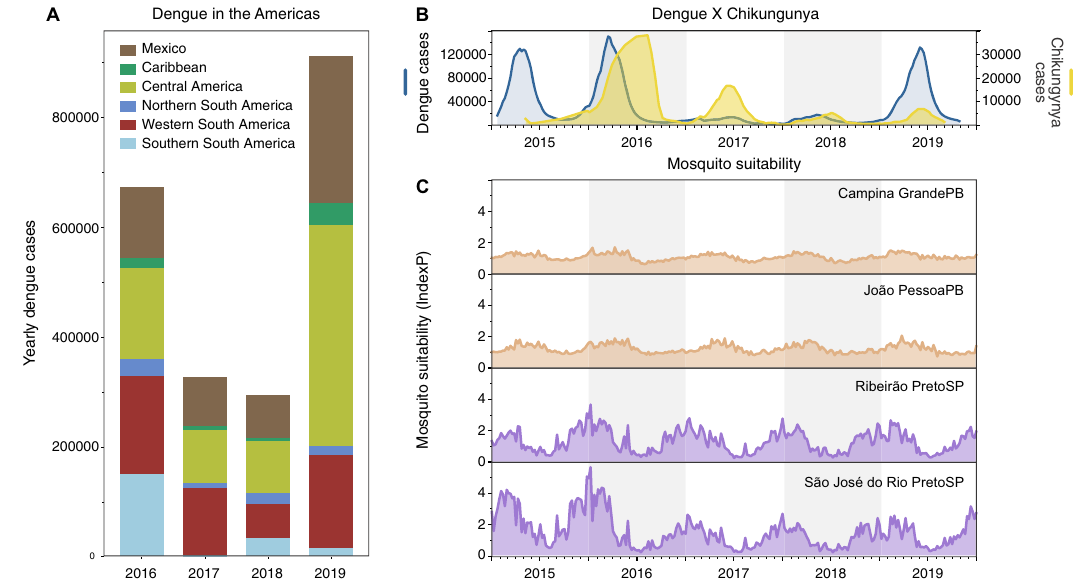
Fig. 4 Low dengue cases in 2017 – 2018 not primarily due to surveillance or climate. A Dengue cases from 2016 to 2019 reported to the Pan American Health Organization aggregated by region in the Americas. A sharp decrease in dengue cases was observed in 2017 – 2018 in distinct subcontinental regions in the Americas: Northern (from Venezuela to French Guyana), Western (from Colombia to Bolivia), and Southern South America (from Paraguay to Argentina), Caribbean, Central America, and Mexico. B In Brazil, the comparative epidemiological curves of dengue and chikungunya cases before and after major Zika outbreaks in 2016. C Measures of Index P, a mosquito-borne viral suitability index (transmission potential), estimated from distinct urban areas in Paraíba (PB, northeast Brazil) and São Paulo (SP, southeast Brazil)